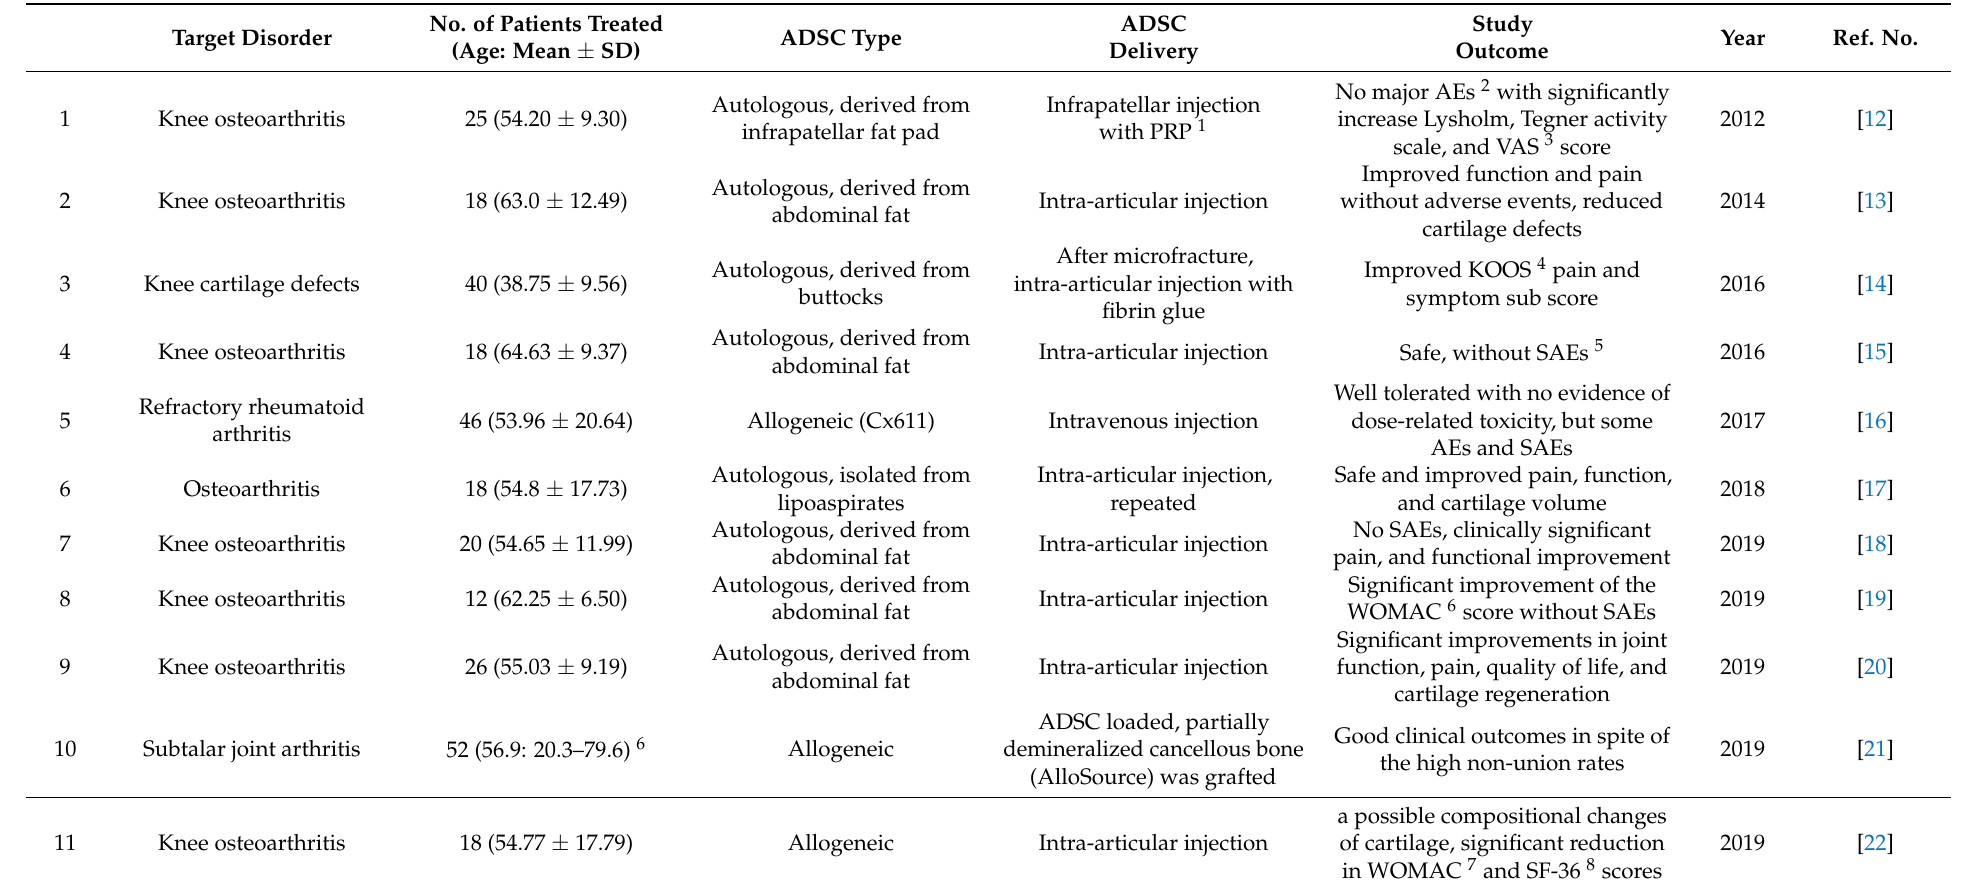
Table 1. Summary of clinical studies examined therapeutic use of hADSCs on arthritis for the last 10